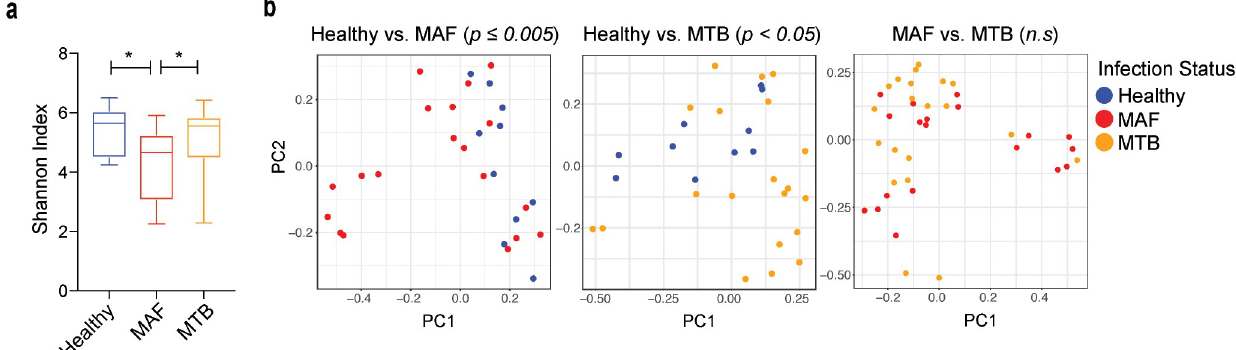
Fig 1. Effect on microbiome diversity and community structure following TB disease caused by MAF and MTB. a. Alpha diversity in the healthy, MAF and MTB groups were estimated using the Shannon index. Error bars indicate minimum and maximum values. Significant differences are indicated. � p < 0.05 (Mann-Whitney U test). b. Beta-diversity estimates were calculated using the Bray-Curtis dissimilarity index and represented here on a principal component (PC) plot. Each circle denotes a single patient and is color-coded by group as indicated in the key. Statistical significance was calculated using PERMANOVA with 999 permutations and is indicated for each comparison ( n . s